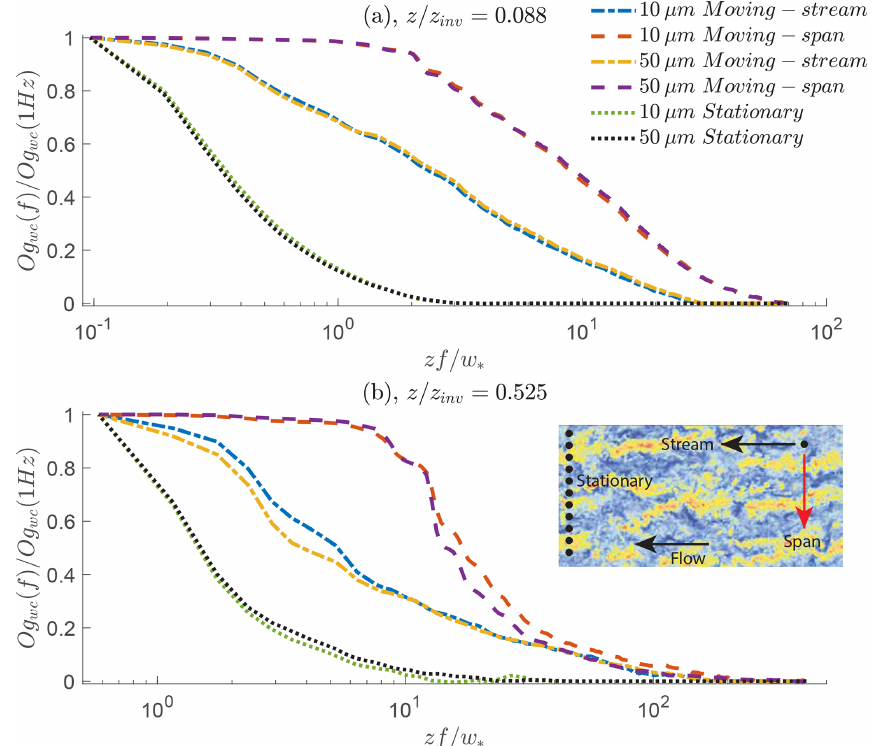
Figure 10. Calculated ogive curves of the net aerosol flux for simulated instrumentation. Moving instrumentation is shown in dashed and dash-dotted lines, while stationary instrumentation is shown in dotted lines at (a) z/z inv = 0 . 083 and (b) z/z inv = 0 . 525. Within the moving probe, streamwise (dash-dotted) and spanwise (dash–dash) are presented. Colors are subsequently used to distinguish the aerosol particle size difference. The sampling duration is 1 T eddy . A small schematic figure containing detail of the simulated instrumentation is provided: the left dots represent the spanwise-placed stationary probes, and the upper right dot represents the aircraft sampling in the specified